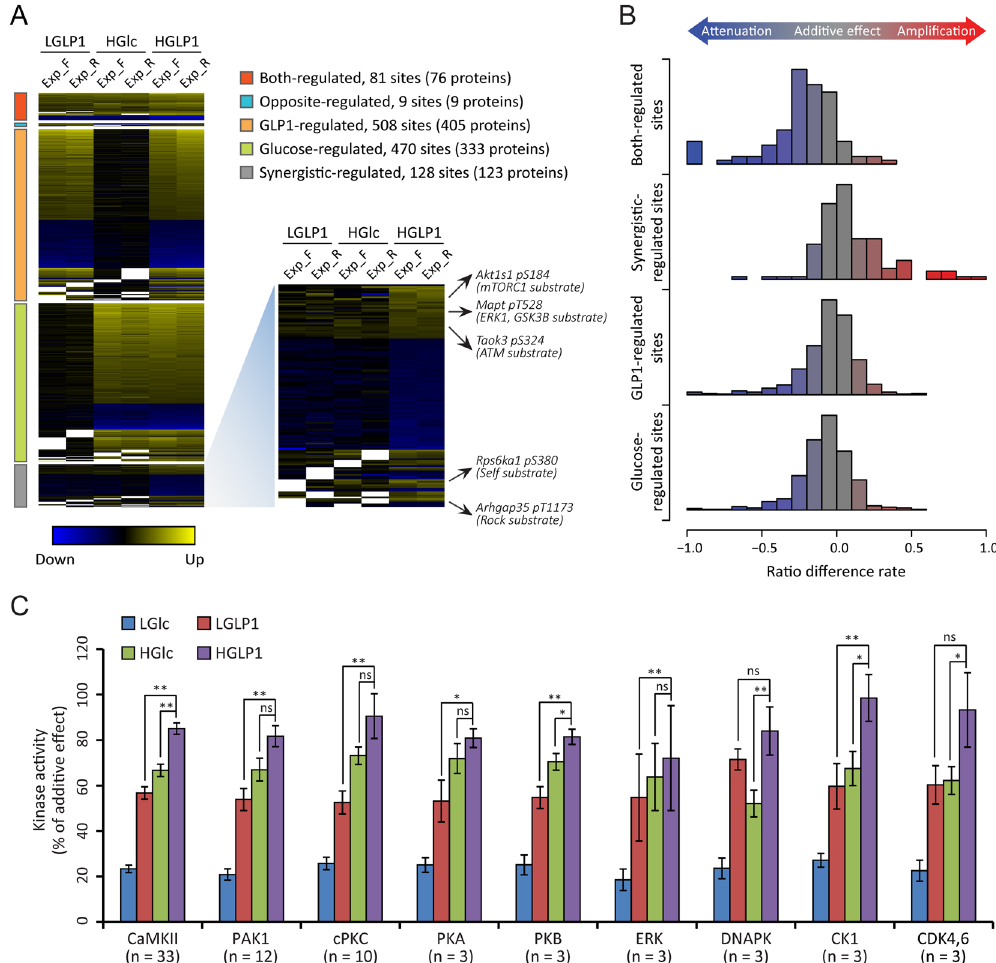
Figure 3. Synergistic regulation of β -cell phosphoproteome mediated by GLP-1 and glucose at site level. (A) Heatmap showing the ratio condition B/A in three experiments for class 1 sites regulated by HGLP1 with high confidence. These phosphorylation sites were classified into 5 categories as defined in Fig. 1G. Synergistic-regulated sites with their biological functions reported are listed, together with their reported kinases. (B) Histogram of the ratio difference rate occurrences showing whether GLP-1 and glucose induced phosphorylation change of each site in an additive manner. All HGLP1 high confidence regulated sites were used for calculation. Ratio difference rate from additive effect was defined in Supplementary Fig. S4. ( C ) Activation of kinases mediated by GLP-1 (LGLP1), glucose (HGlc) or their synergism (HGLP1) according to the phosphorylation status of their substrates predicted by NetworKIN algorithm. Only both-regulated sites mediated by GLP-1 and glucose were used for kinase activation calculation. Phosphorylation status of each site according to each treatment were divided by ratio_additive as defined in Supplemental Fig. S4. Paired Student’s t-test for each site was applied to calculate the significance of activation status of their predicted kinase. ns, non- significant. * p < 0.05; ** p < 0.01 (paired Student’s t test). Data were represented in mean ± SEM. n stands for the number of predicted substrates of each